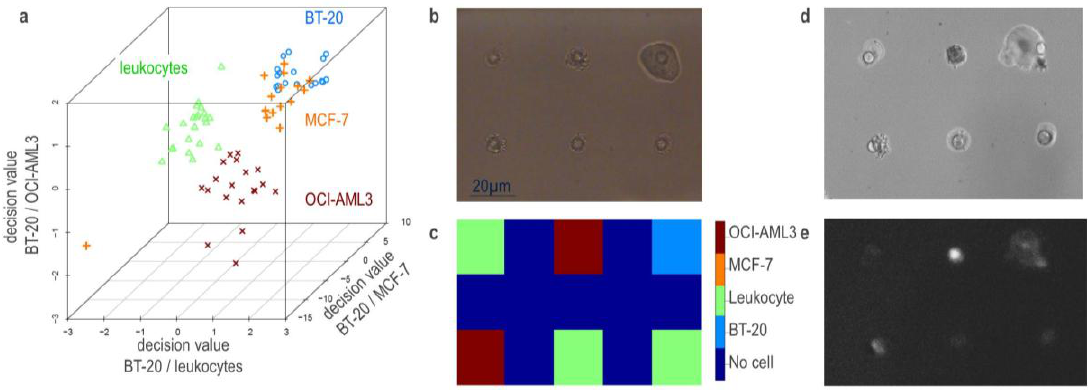
Figure 4. ( a ) Decision value plot of the support vector machine (SVM) model; ( b ) white light image of unknown cells in mixture; and ( c ) Raman based assignment of those cells; ( d ) after the measurement the cells were dried on the membrane; and ( e ) investigated by fluorescence microscopy with 488 nm excitation and a bandpass filter 565–615 nm. (fluorescence dyes used: PerCP for OCI-AML3 and FITC for